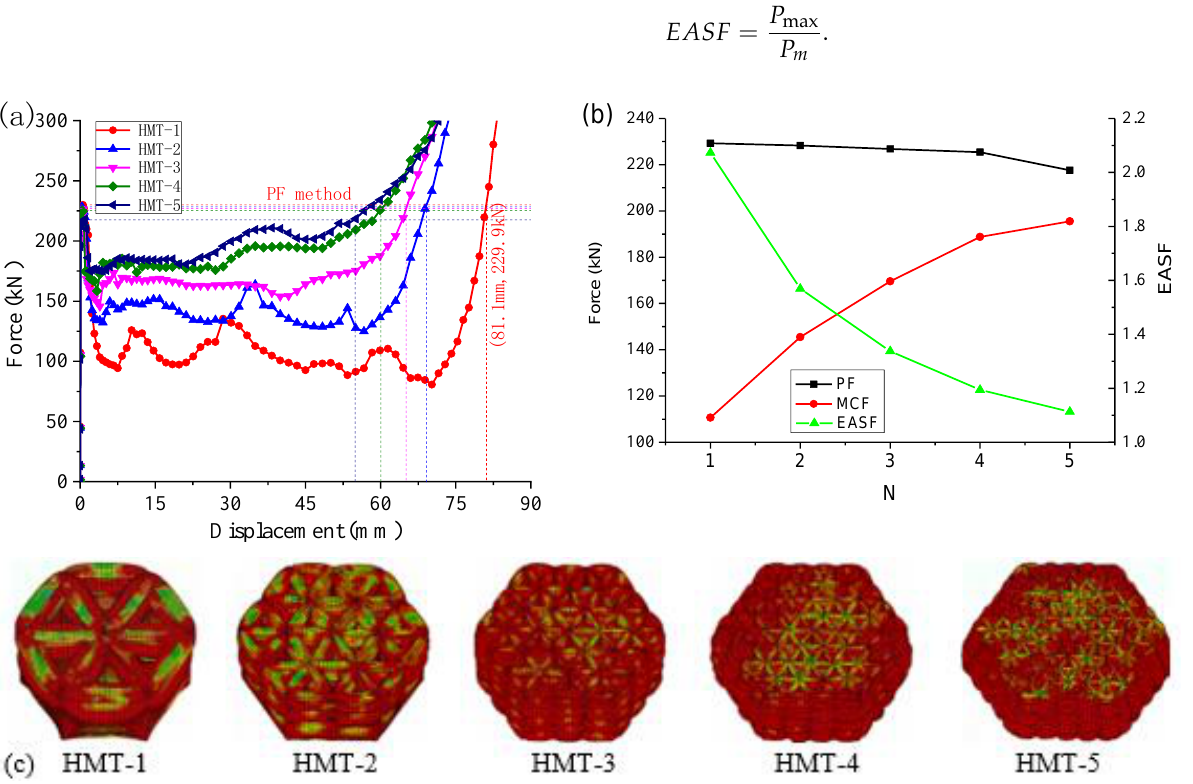
Figure 13. The crushing performance of multi-cell thin wall tube: ( a ) force–displacement curves, ( b ) energy absorption parameters curves, and ( c ) folding modes.